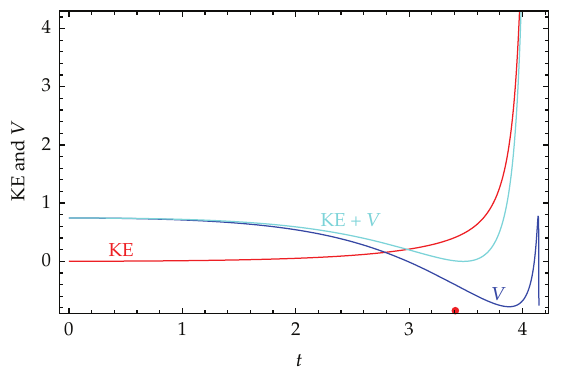
Figure 9: Scalar field kinetic energy density ˙ φ 2 / 2 and potential energy density V (cid:2) φ (cid:3) versus t/t 0 . The dot indicates t ∗